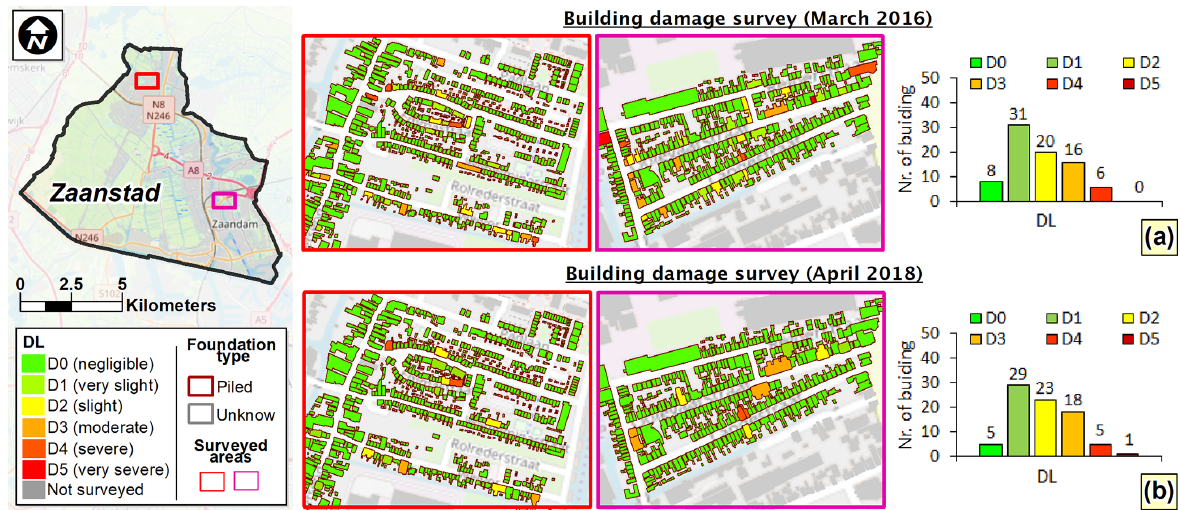
Figure 2. Maps of multi-temporal building damage surveys carried out in (a) March 2016 and (b) April 2018 and distributions of the recorded DL on 81 masonry buildings with pile foundation considered for the analysis. Source: Image from